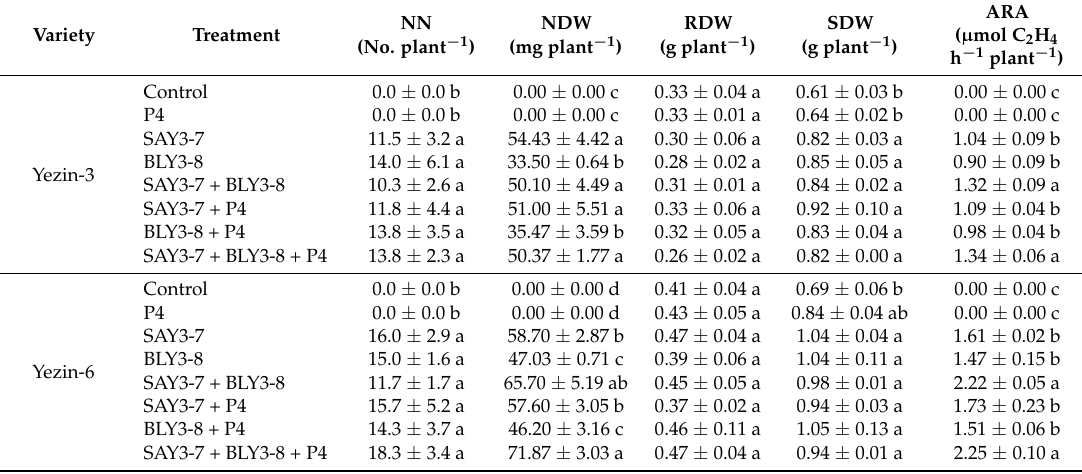
Table 1. Effect of inoculation of B. japonicum SAY3-7, B. elkanii BLY3-8 and S. griseoflavus P4 on nodule acetylene reducing activity (ARA) of soybeans at 30 days after